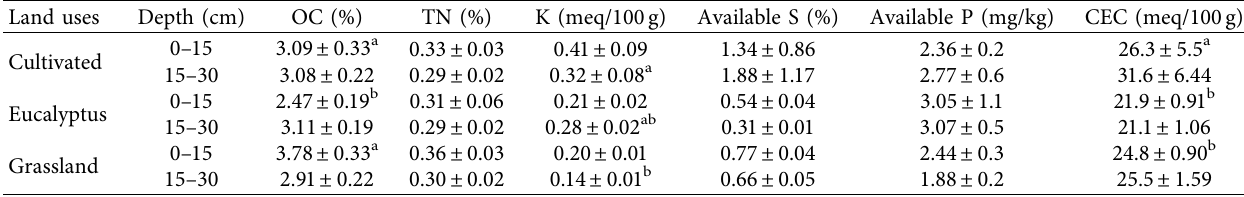
Table 3: Mean ( ± SEM) of selected soil chemical properties across land uses and soil depths. Land uses